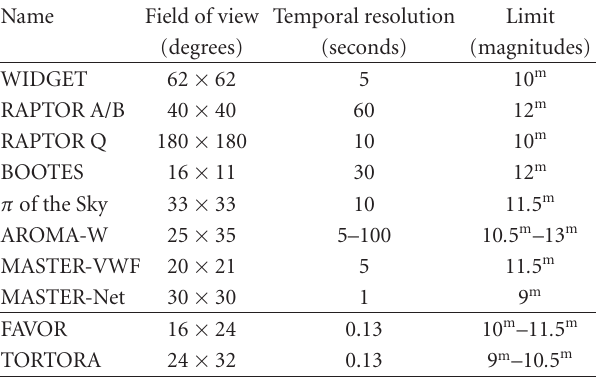
Table 1: Wide-field monitoring cameras currently in operation. For FAVOR and TORTORA the limits correspond to 3 σ detection on a single frame, and di ff er from their real-time operational